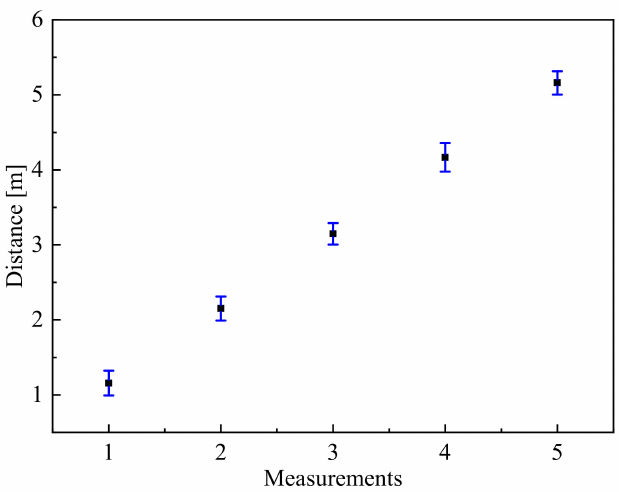
Figure 9. Standard deviation at different distances. Each error bar is the standard deviation from 20 measurements and the magnitudes of the error bars are scaled up by 500-fold for